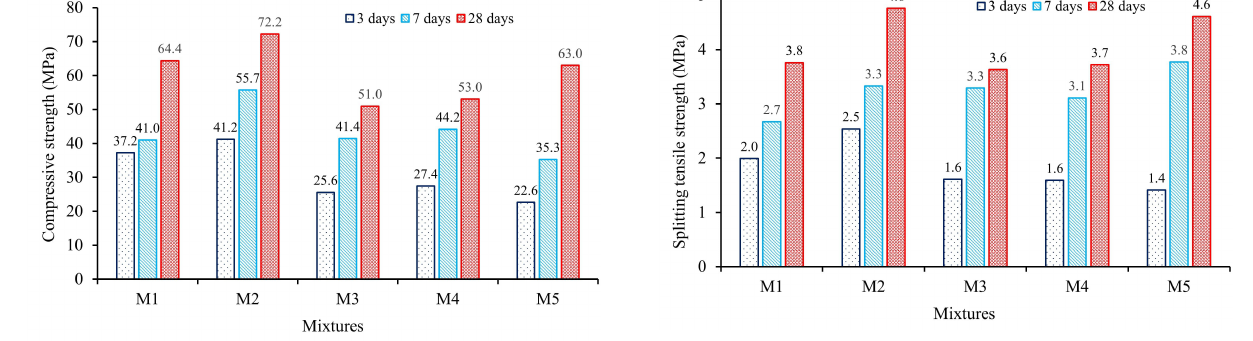
Fig. 3. Compressive strength of all mixtures.